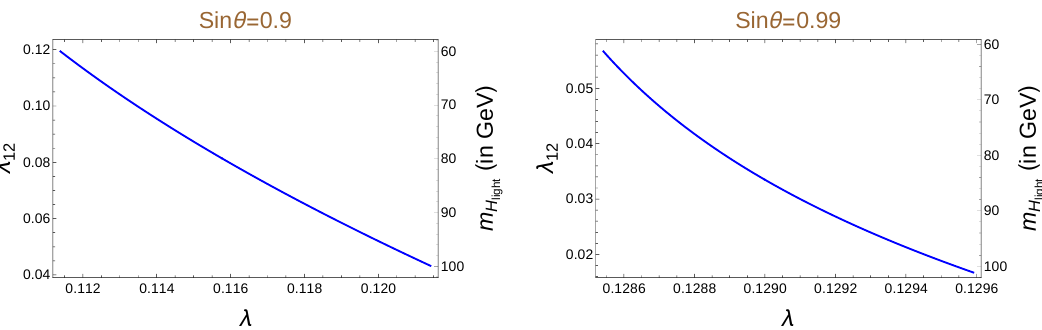
= 125 : 7 GeV with SM Higgs vev v = 246 GeV. SM